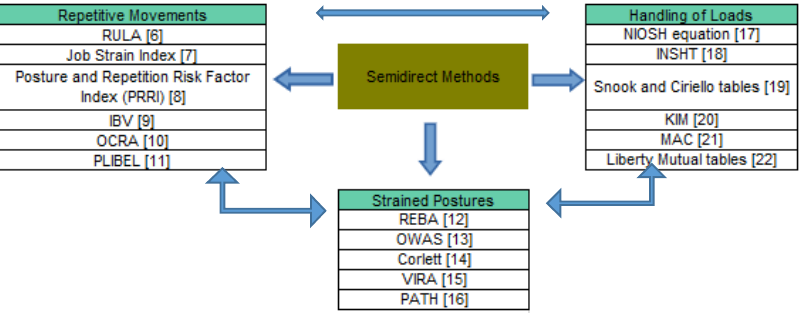
Figure 1. Semi-direct methods according to the cause of the musculoskeletal disorders and their combined use (adapted from Reference [5]). Rapid Upper Limb Assessment (RULA) [6]; Job